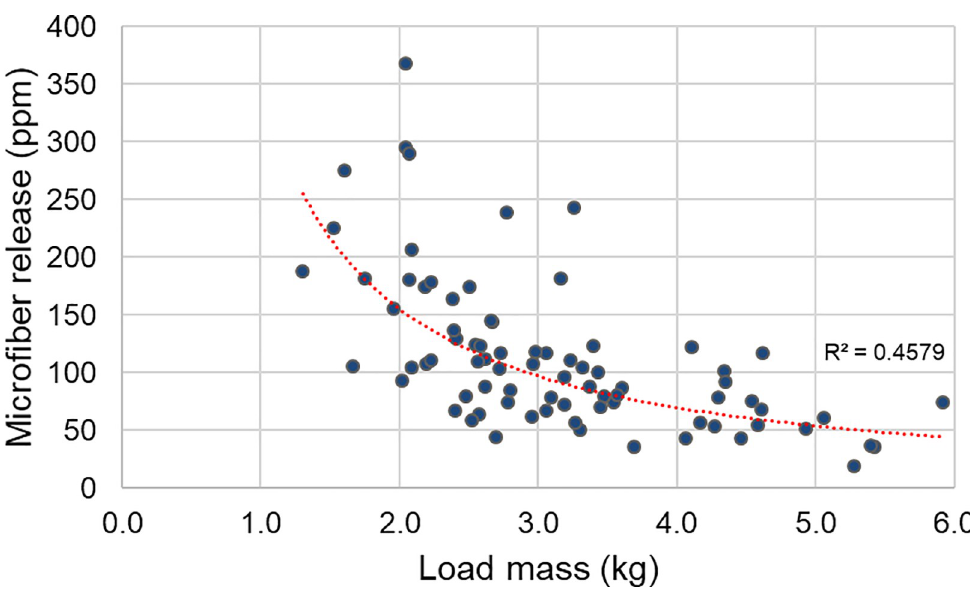
Fig 2. Correlation of microfiber release from 79 European soiled consumer wash loads against load mass (n = 79). The trend line relates to the equation y = 346.23x -1.158 ; R 2 = 0.46; p = 7.6 x 10 − 12 .